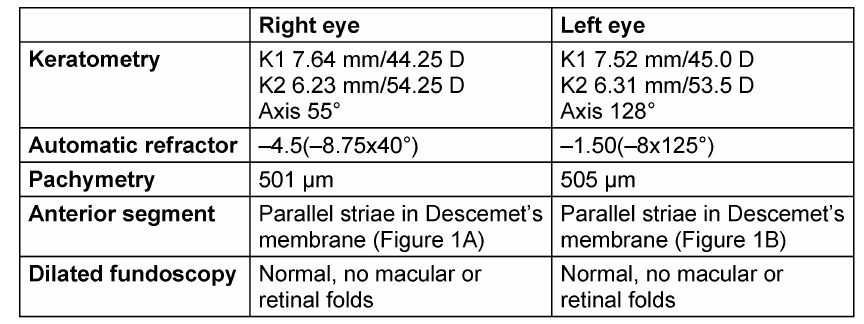
Table 1: Results of the examination under general